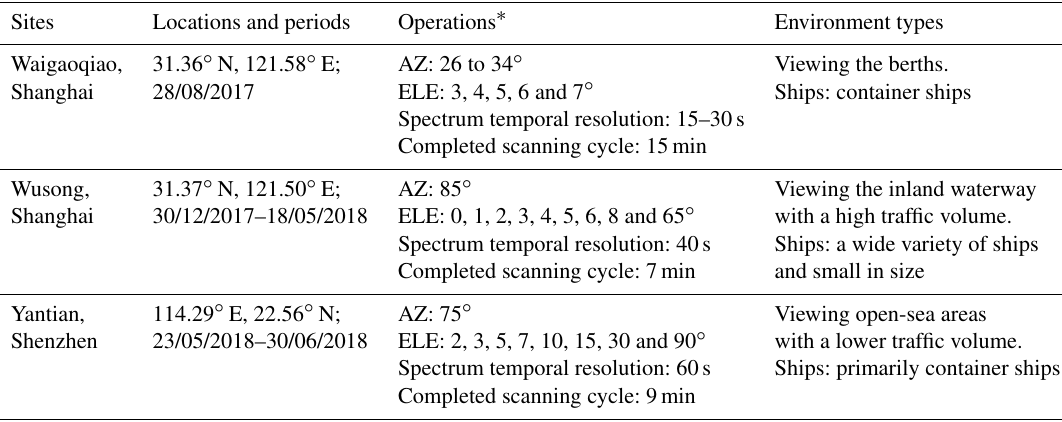
Table 1. Measurement details and the operational configurations of the MAX-DOAS. Sites Locations and